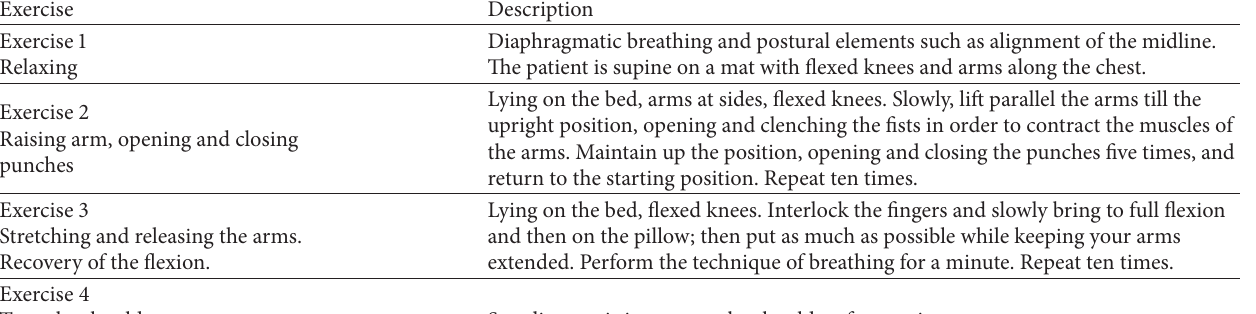
Table 1: Exercises’